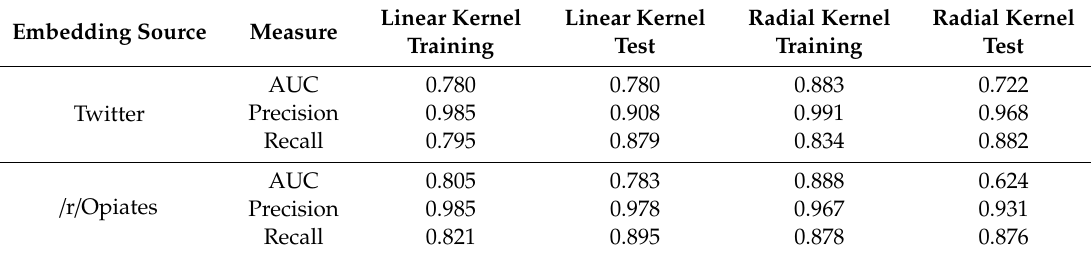
Table 1. Support vector machine (SVM) performance on classifying authors as originating from the subreddits / r / Opiates or / r / CasualConversation. Models were trained on 30,000 authors and tested on 6000 authors, giving a margin of error of ± 0.013 for these estimates at the 95% confidence